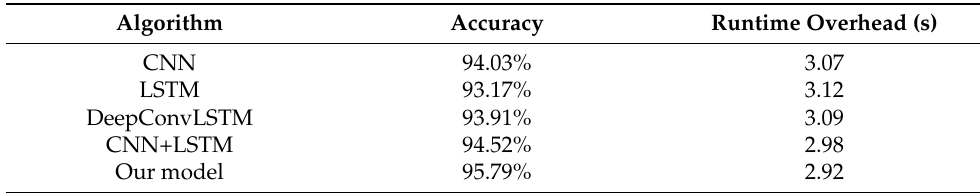
Table 3. User identification accuracy with different advanced networks.